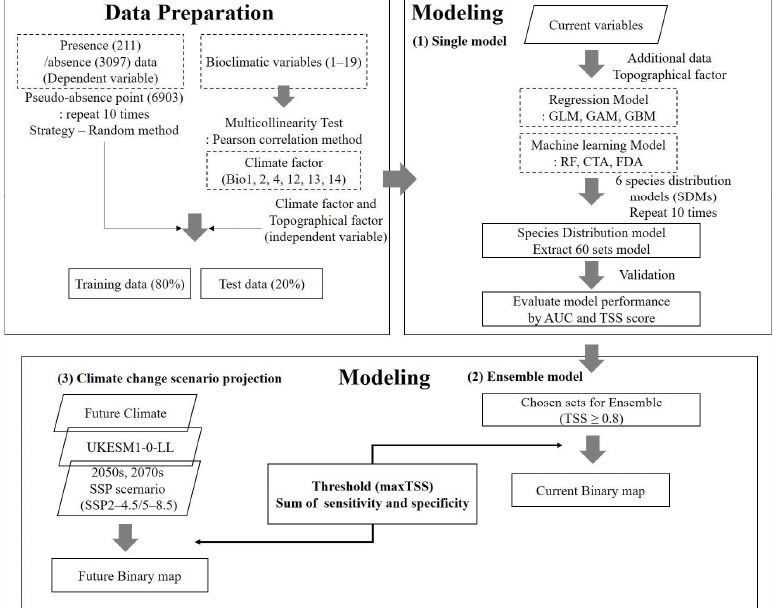
Figure 2. Ensemble species distribution modeling flow chart.